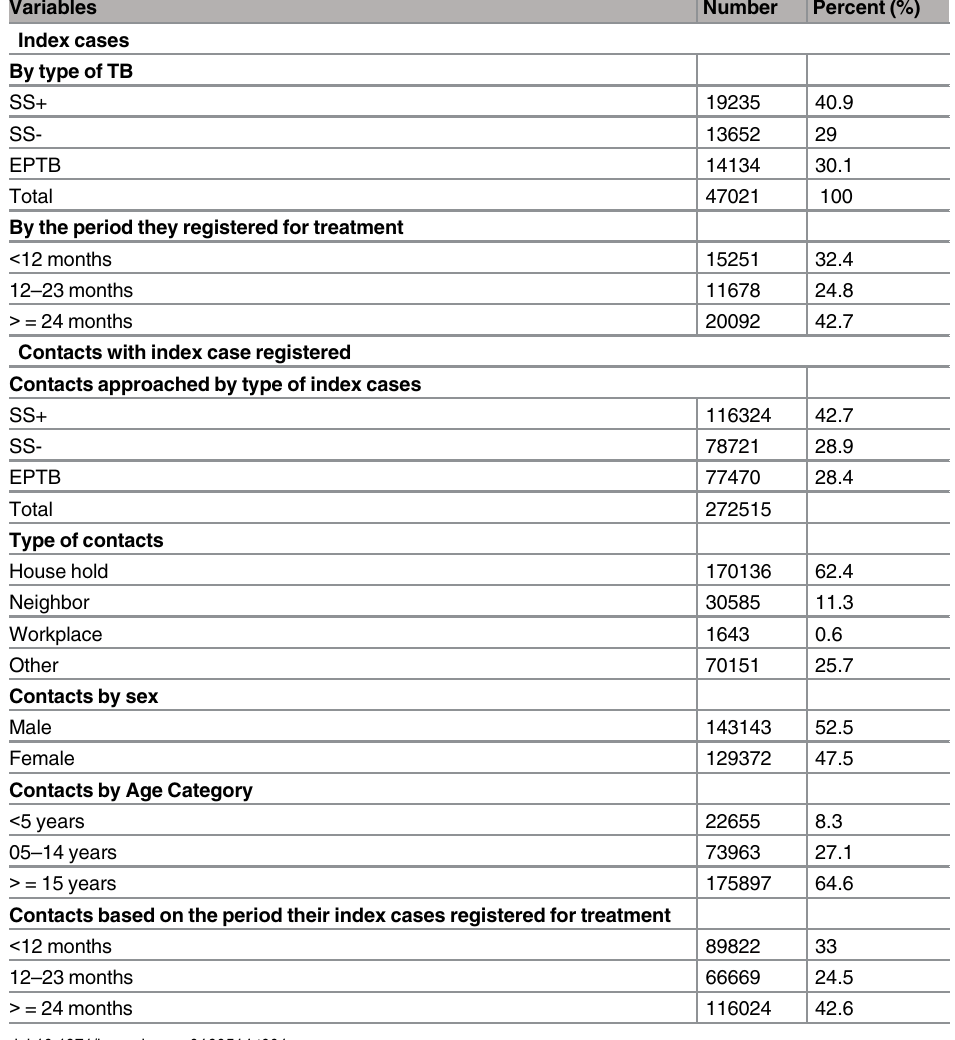
Table 1. Characteristics of index cases registered and contacts with index cases approached for screening in the six study zones, June-October 2014,